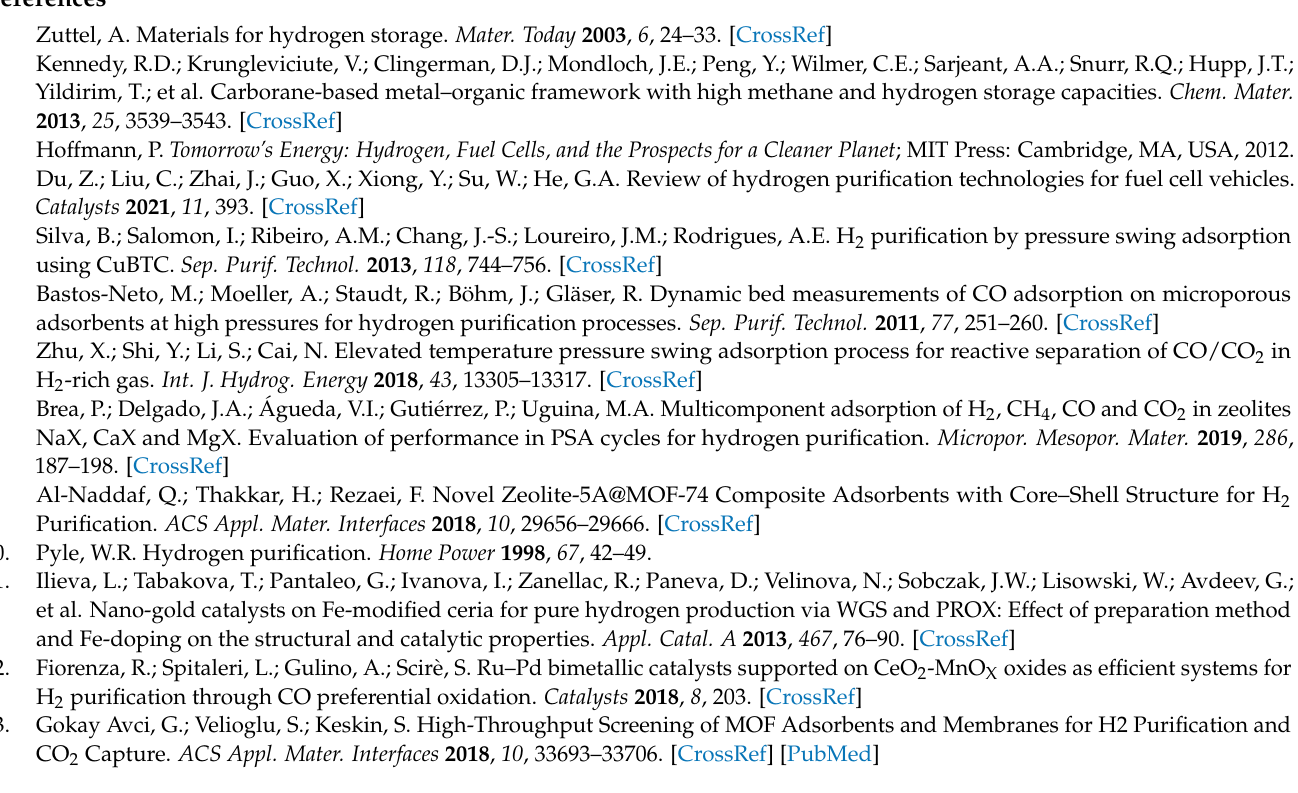
Figure S3: H 2 -TPR profiles of 6.4CuZ27(SE), Figure S4: CO-TPD curves of 6.4CuZ27(SE), Figure S5: CO-TPD curves obtained after CO adsorption at different temperatures on 9.7CuZ23(SE), Figure S6: Breakthrough curves of CO on 6.4CuZ27(SE) at different conditions, Figure S7: Breakthrough curves of CO on 6.4CuZ27(SE) at different humidity, Figure S8: Breakthrough curves of CO on differently pre-treated 3.1CuZ23(AE), Figure S9: Breakthrough curves of CO on 6.4CuZ27(SE) and 9.7CuZ23(SE), Figure S10: Subsequent cycles of adsorption/desorption of CO on